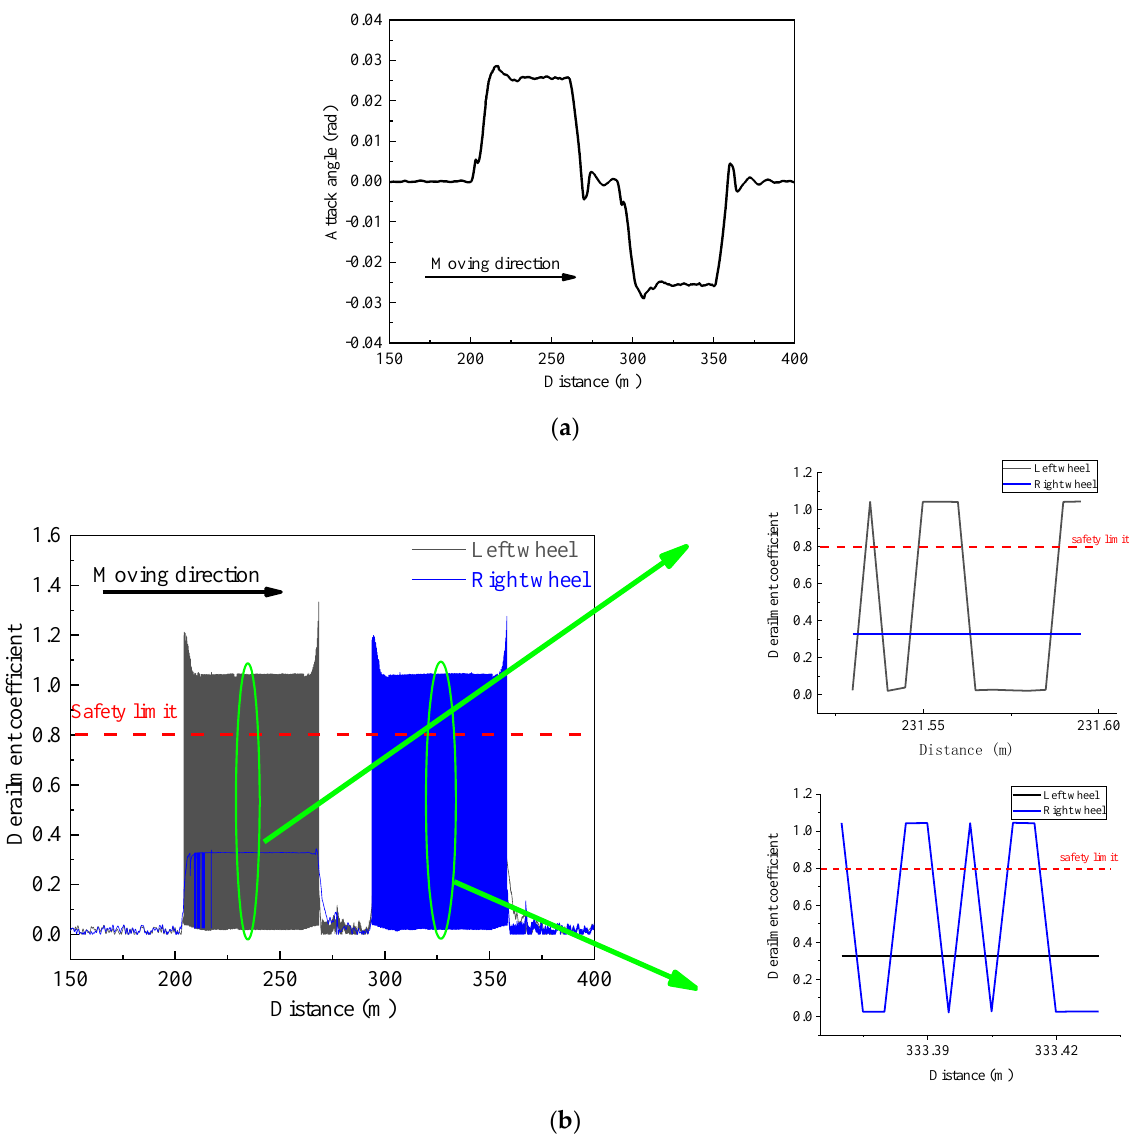
Figure 11. Attack angle and derailment coefficient: ( a ) attack angle of the wheelset; ( b ) derailment coefficient.